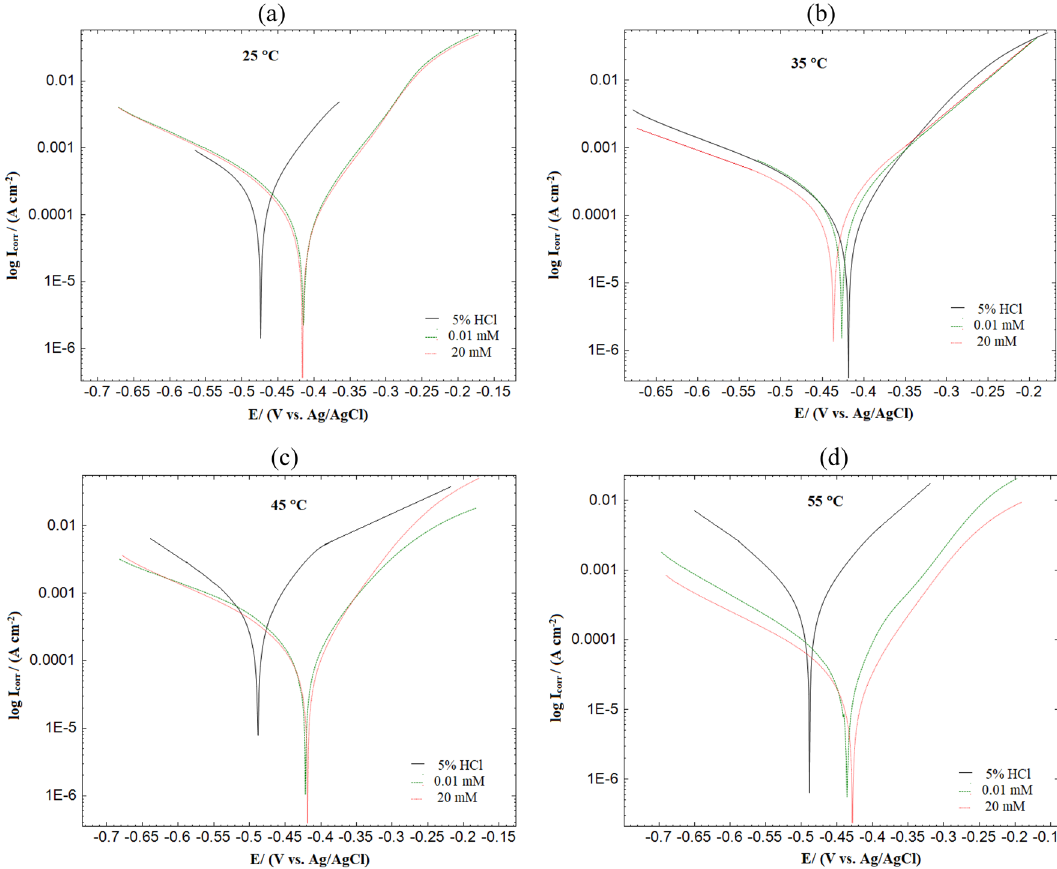
Figure 7. Polarization curves for MS in 5% HCl solution in the absence and presence of different concentration of drug at ( a ) 25 °C, ( b ) 35 °C, ( c ) 45 °C, ( d ) 55 °C.